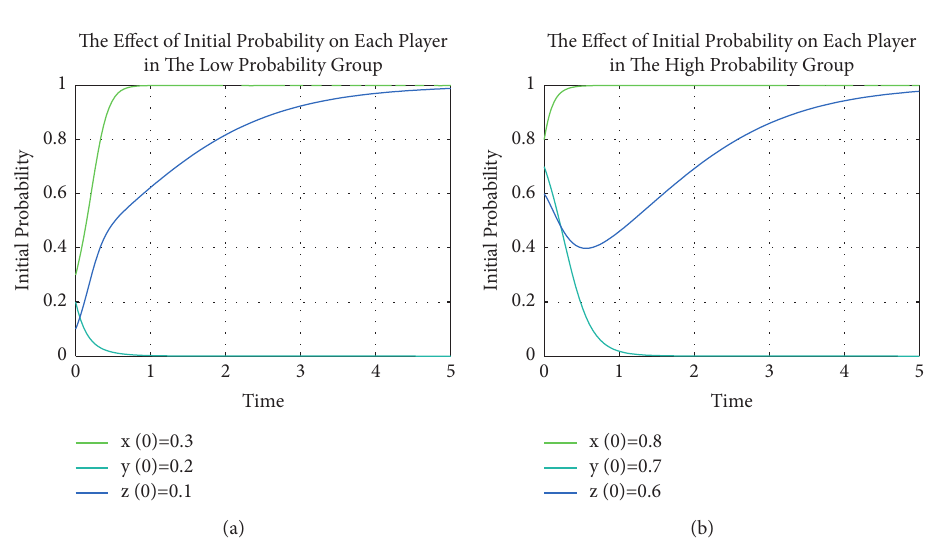
Figure 3: The effect of initial probability on each player in two groups. (a) The effect of initial probability on each player in the low probability group. (b) The effect of initial probability on each player in the high probability group. Table 6: The values of parameters in the simulation of environmental protection cost ( C